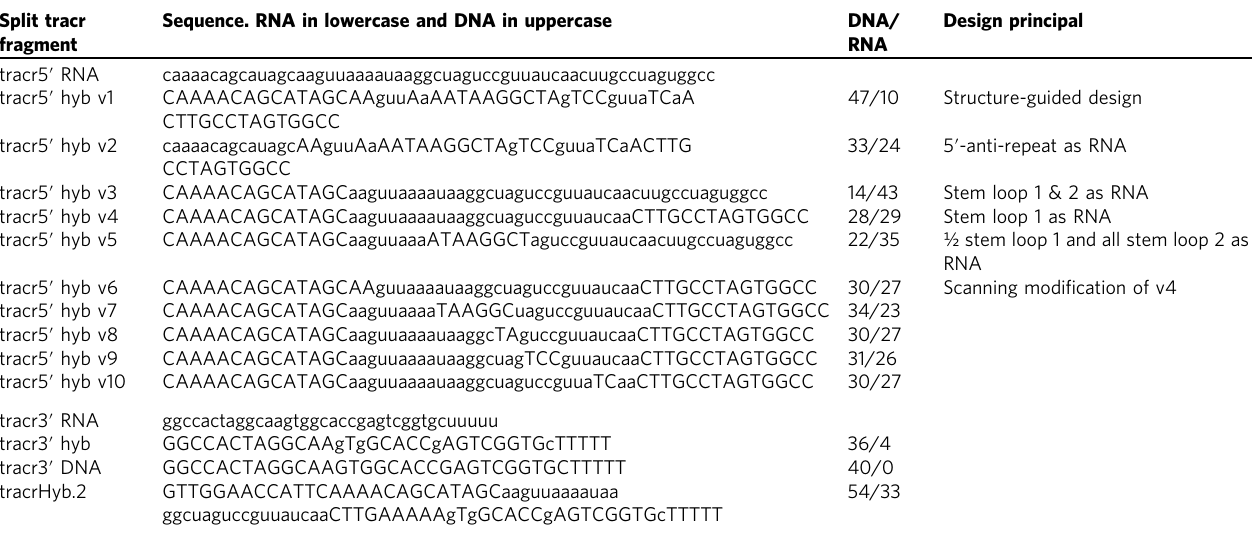
Table 1 Split tracr fragments sequences Split tracr Sequence. RNA in lowercase and DNA in fragment